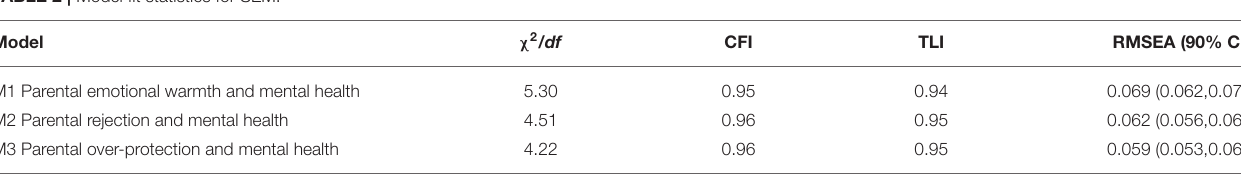
TABLE 2 | Model fit statistics for SEM.